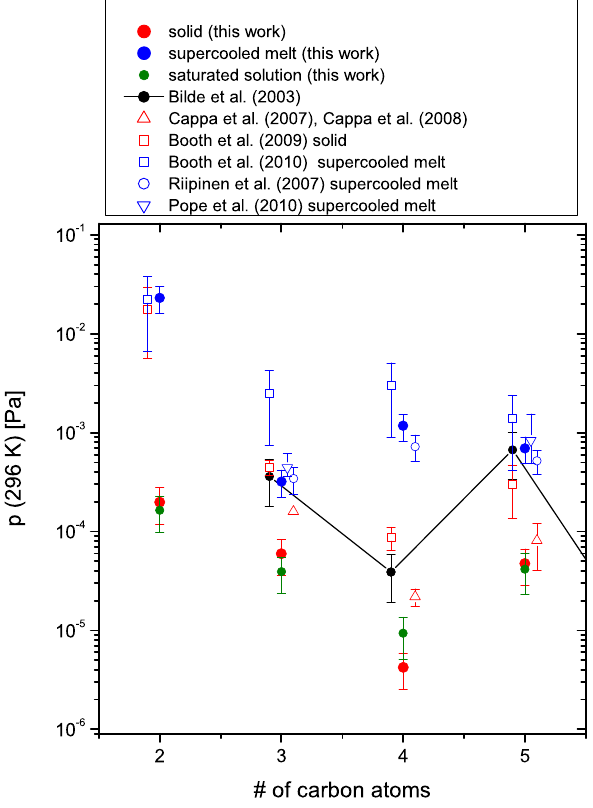
Fig. 13. Vapor pressures of dicarboxylic acids versus number of carbon atoms at T = 296K. Our data and selected literature data are plotted as indicated in the figure. (For clarity literature data are shifted slightly in carbon